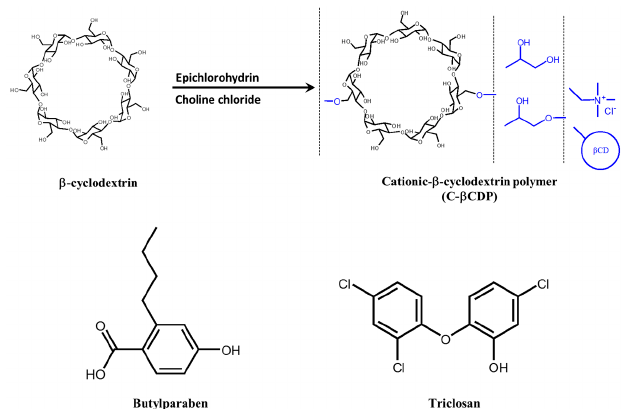
Figure 3. Synthesis of cationic β -cyclodextrin polymer and chemical structure of butylparaben and triclosan.